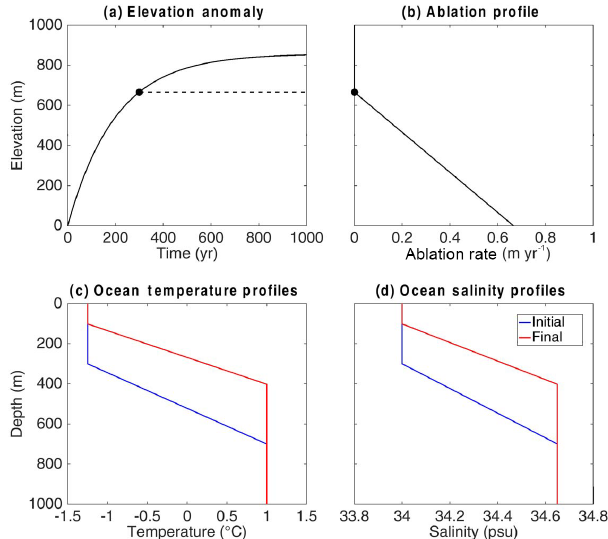
Figure 4. Climate forcing used for the warming runs. Panel (a) shows the asymptotically rising elevation of ablation, panel (b) shows the annually averaged ablation profile below that elevation, and panels (c) and (d) show the shoaling Circumpolar Deep Water. The ablation rate in any year is computed by taking the elevation of zero ablation in that year (black dot in a and b ) and applying the lapse rate shown in (b) . Ablation is only applied during a 4-month summer ablation season, so the instantaneous ablation rate is higher than the annual average shown in (b) . Net surface mass balance is the sum of the vertically variable ablation rate and the horizontally variable accumulation rate (not